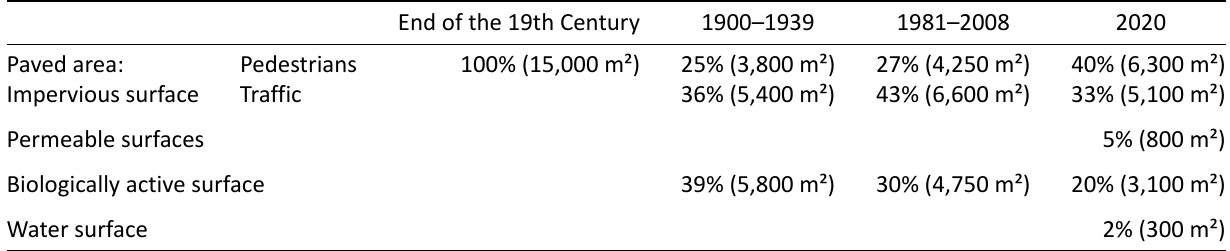
Table 4. Grzybowski Square, Warsaw: Percentage share of different surfaces in the area of the square.